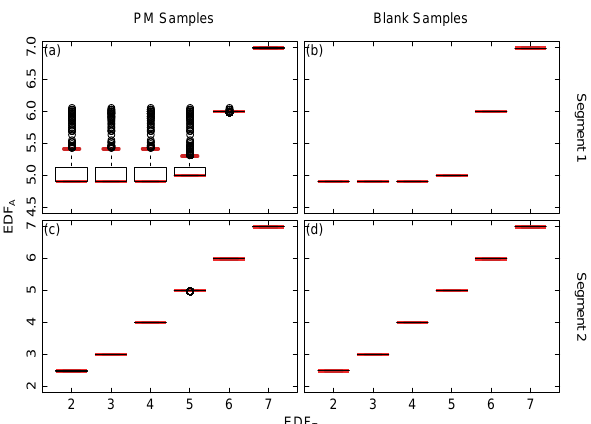
Figure 5. Box-and-whisker plots representing distributions of EDF A for a given EDF T used in Segment 1 (a, b) and Segment 2 (c, d) in both PM ( n = 794) and blank samples ( n = 54). Median and whiskers in each box-and-whisker plot are highlighted in